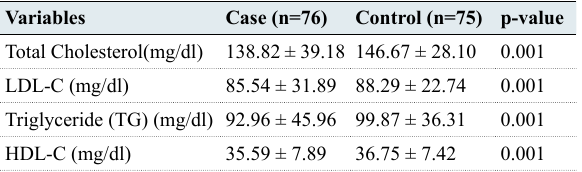
Table 2: Comparison of lipid profile parameters in case and control Variables Case (n=76) Control (n=75) p-value Total Cholesterol(mg/dl) 138.82 ± 39.18 146.67 ± 28.10 0.001 LDL-C (mg/dl) 85.54 ± 31.89 88.29 ± 22.74 0.001